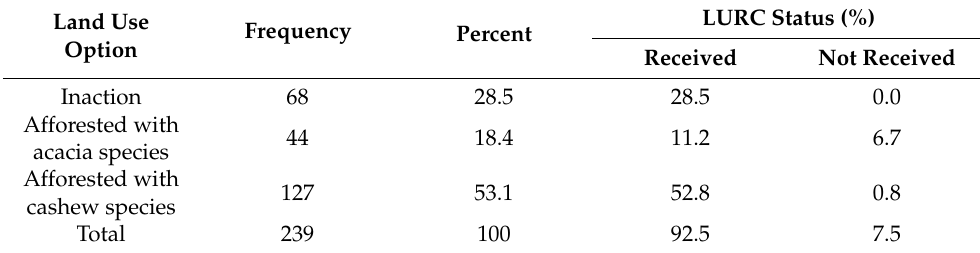
Table 1. Afforestation decision of the surveyed